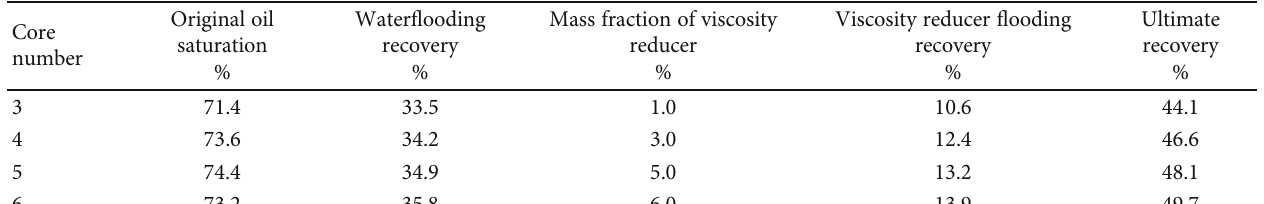
Table 3: Table of oil production performance.